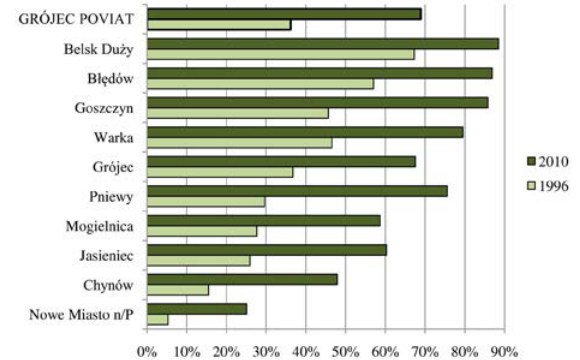
Fig. 5. The proportion of orchards in the structure of agricultural land in Grójec poviat and its communes in 1996 and 2010.